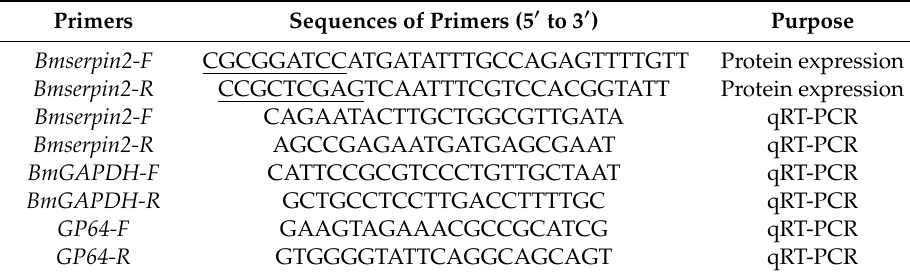
Table 1. The primers used in this